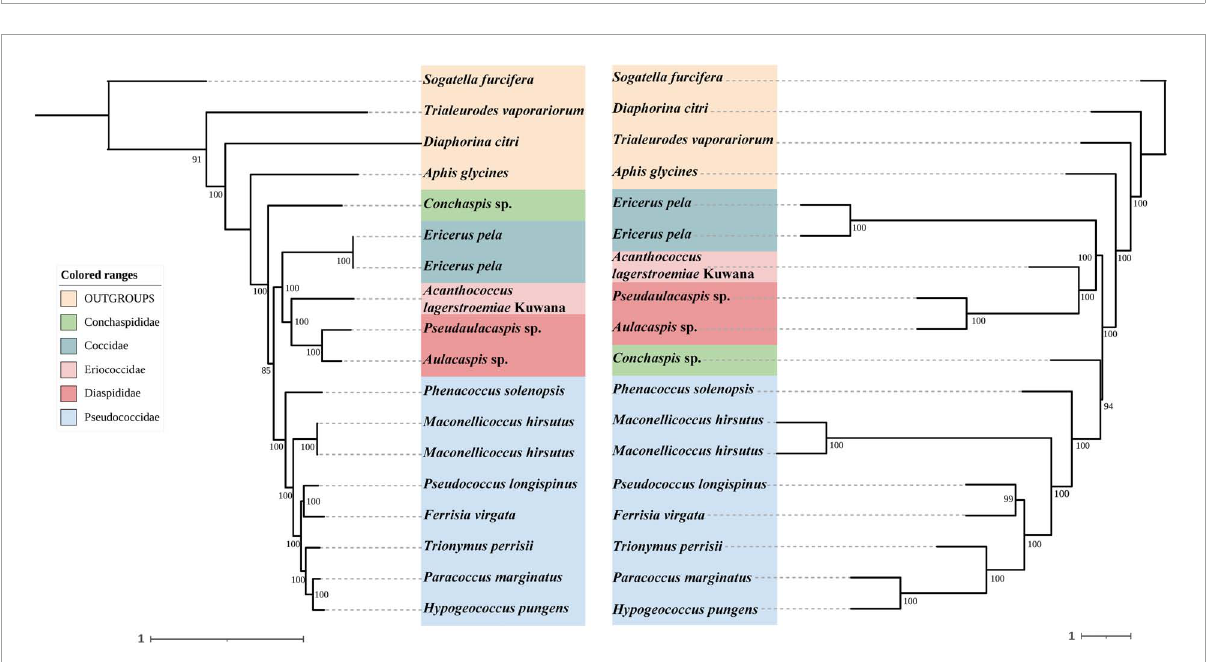
FIGURE6 Left: Concatenated tree of 85% completeness matrices from Hemiptera probe set. Node values are bootstrap support. Right: Species tree of 85% completeness matrices from Hemiptera probe set. Node values are bootstrap